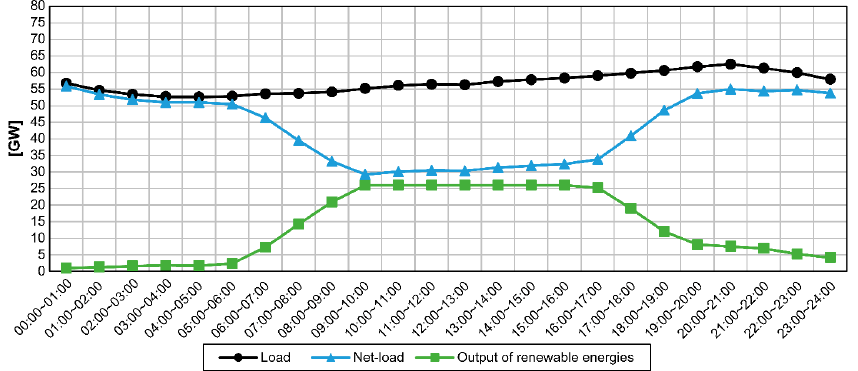
Figure 9. Curves of load, net-load, and VRE output power on spring Sunday, 2030.